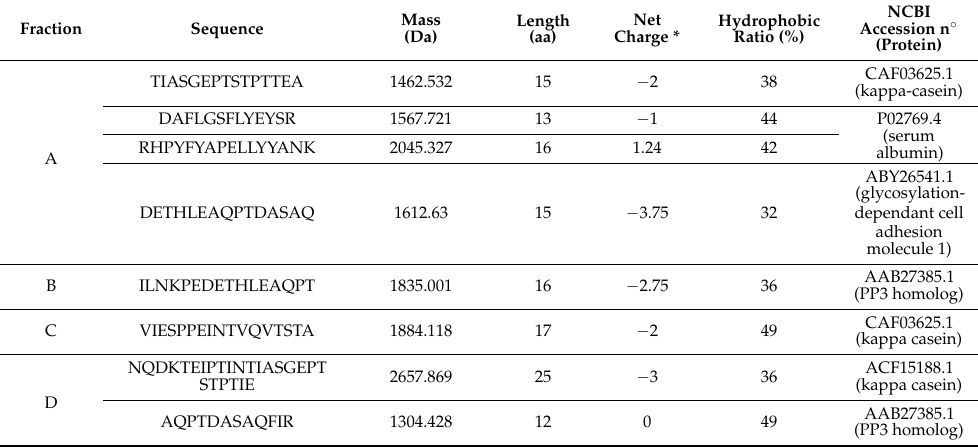
Table 4. List of the peptides identified in the partially purified peptide fractions obtained from the fR-UF through RP-FPLC. Fermentation was carried out with Lactobacillus helveticus PR4 at 37 ◦ C for 24 h.